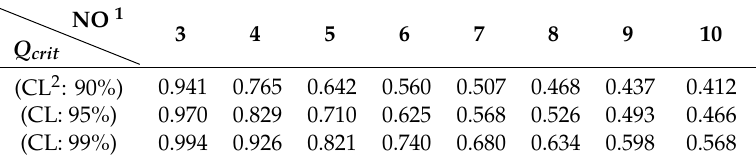
Table 2. Critical Values for Q Test of a Single Outlier ( Q 10